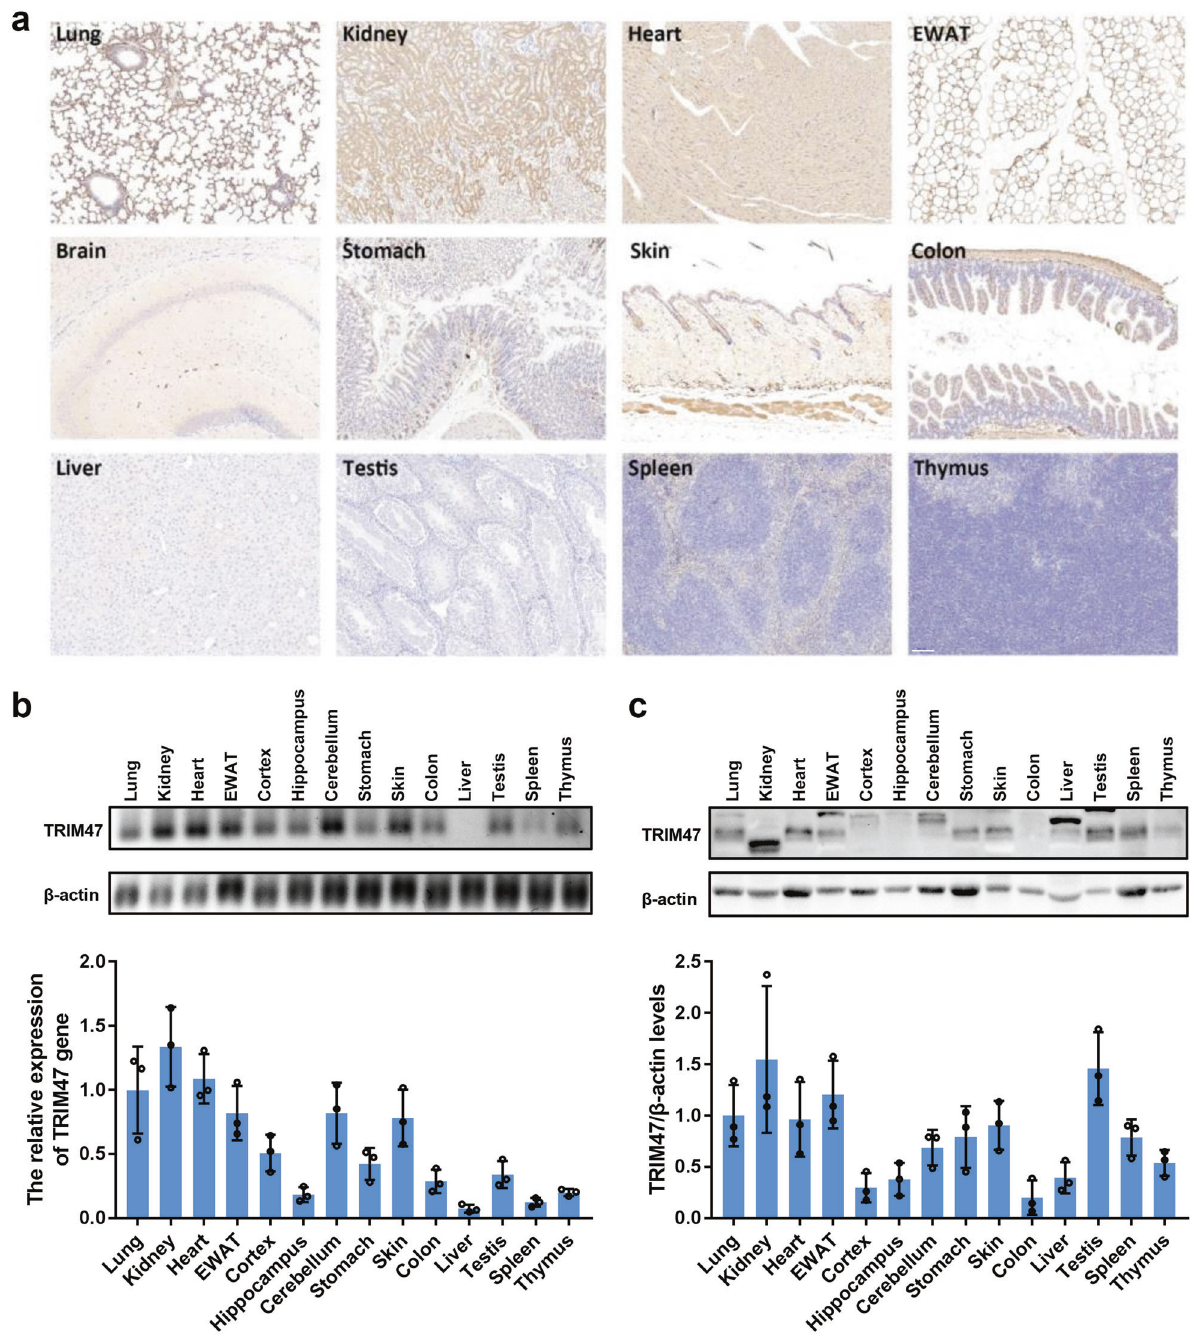
Fig. 1 Expression of TRIM47 in tissues of mice. a Representative images of TRIM47 distribution in different tissues detected by immunohistochemistry ( n = 3). Scale bar, 100 μ m. b Representative images of agarose gel electrophoresis of TIRM47 and β -actin in various tissues of mice detected by real-time PCR (up) and the relative quantitation of TRIM47 expression (down, n = 3). c Representative images of the immunoblots of TIRM47 and β -actin in various tissues of mice detected by western blot (up) and the relative quantitation of TIRM47 protein levels (down, n =